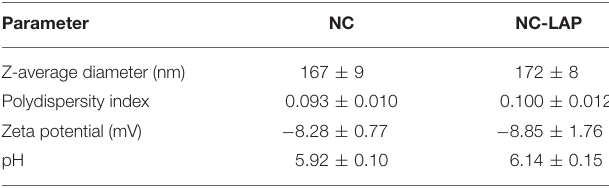
TABLE 2 | Results of physicochemical characterization of nanocapsule